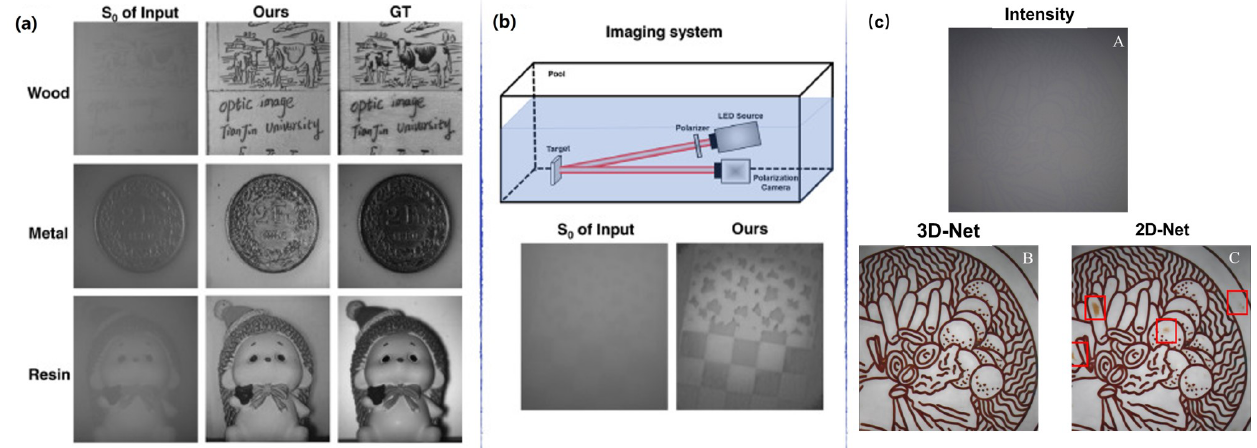
Figure 17. ( a ) Recovered results for different materials and the experiment in the natural underwater environment. ( b ) The imaging system includes a target board, a homemade polarized light source, and a polarization camera [64]. ( c ) Comparison of 3D- and 2D-Network for underwater color polarized images [231], where A is the intensity image, B and C are the results related to 3D-Net and 2D-Net,